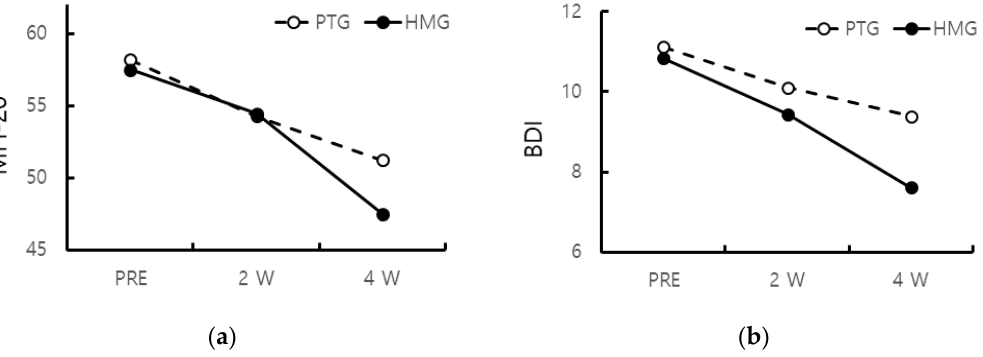
Figure 2. ( a ) MFI-20 of both groups were improved from 2 W, and the MFI-20 of the HMG improved from 4 W compared to that of the PTG ( p < 0.05); ( b ) BDI of the PTG was improved at 4 W compared to PRE and 2 W, but that of the HMG was improved at 2 W ( p < 0.05). (MFI-20: multidimensional fatigue inventory 20, BDI: Beck’s depression inventory).